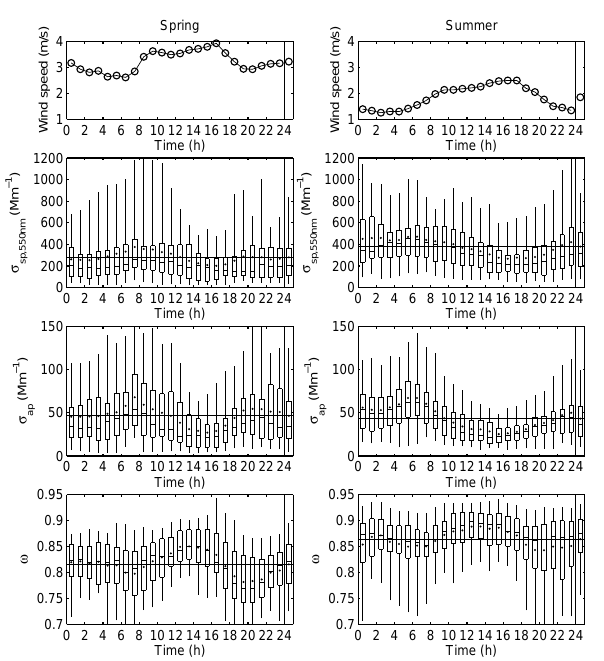
Fig. 4. The average diurnal cycle of wind speed, σ sp , σ ap and ω . The left 4 pictures are for spring and the right ones are for summer. In each picture, the boxes and whiskers denote the 5, 25, 50, 75 and 95 percentiles, while the dots denote the mean values. The x-axis denotes the time of day, with the last box-and-whisker denoting the percentile and mean value for the entire period. The horizontal line also denotes the mean value for the entire study